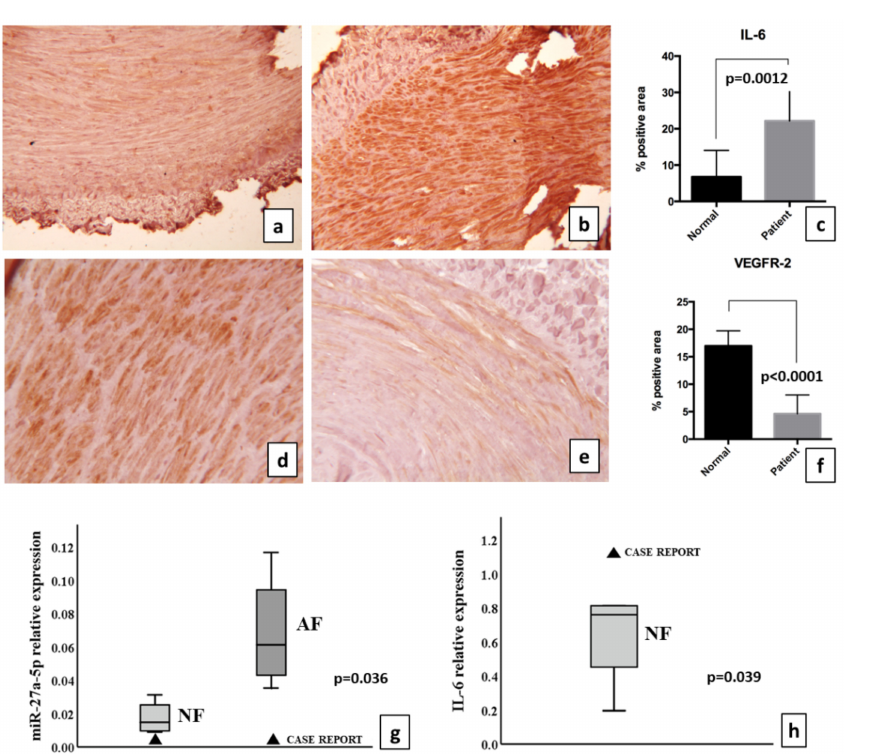
Figure 2. Immunohistochemical and molecular characterization of the case report. Detection of IL-6 in ( a ) normal femoral artery and ( b ) case report; ( c ) quantification of tissue area percentage positive to IL-6, significantly higher in the case report ( p = 0.0012). Detection of VEGFR-2 in ( d ) the normal femoral artery and ( e ) case report; ( f ) the quantification of the tissue area percentage positive for VEGFR-2, significantly lower in the case report ( p < 0.0001). ( g ) Real-time RT-PCR analysis of miR-27a-5p; the single value of the case report is compared with normal femoral arteries as a box plot (not significant) and with atherosclerotic femoral arteries as a box plot ( p = 0.036, z -score test). ( h ) mRNA levels of IL-6 in normal femoral arteries and the case report; the single value of the case report is compared with the normal femoral arteries as a box plot ( p = 0.039, z -score test). Triangles represent the case report. Abbreviations: NF: normal femoral artery; AF: atherosclerotic femoral